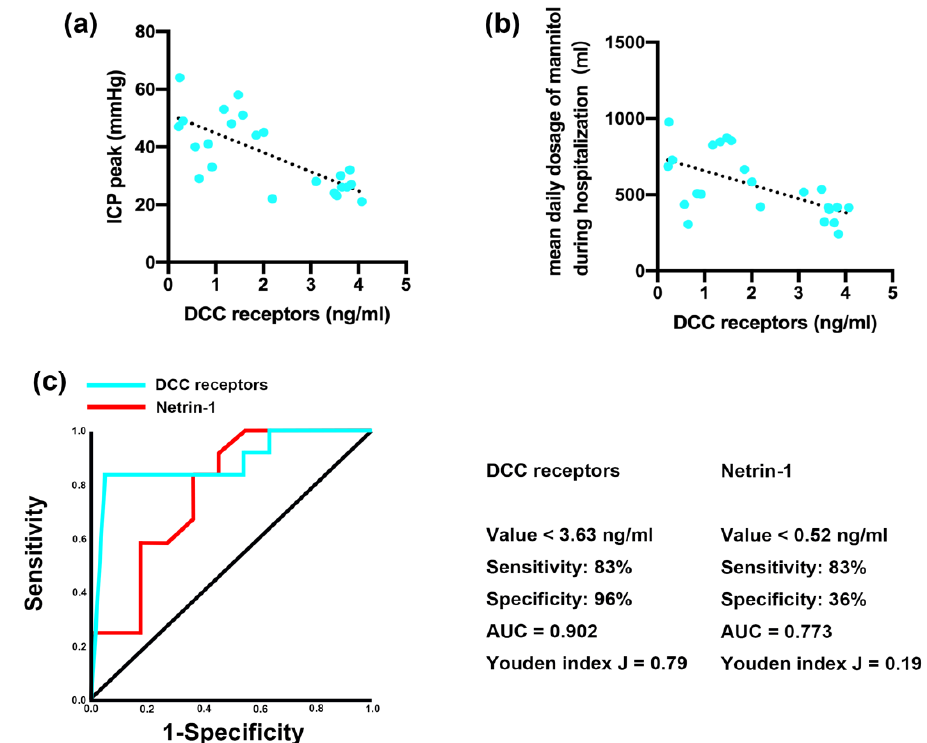
Figure 4. The respective relations between the protein concentration of DCC receptors and the postoperative intracranial pressure; sensitivity to dehydration therapy. ( a ) The relationship between the protein concentration of DCC receptors and the postoperative intracranial pressure. ( b ) The relationship between the protein concentration of DCC receptors and the average mannitol consumption. ( c ) Receiver operating characteristic curve for analyzing predictive ability regarding protein concentration of DCC receptors and serum Netrin-1 concentrations for high postoperative intracranial pressure.